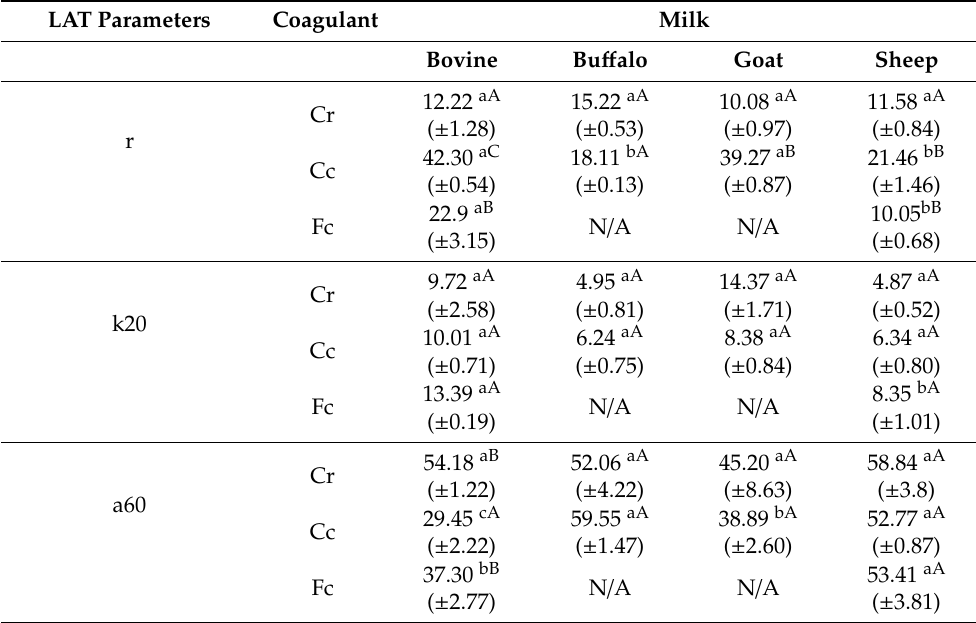
Table 3. Lactodynamographic (LAT) parameters measured for C. cardunculus (Cc), calf rennet (Cr) and F. carica (Fc) extracts in bovine, bu ff alo, goat and sheep milks at 35 ◦